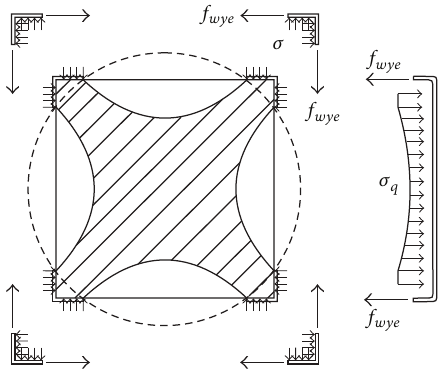
Figure 6: Restraint stress of cross